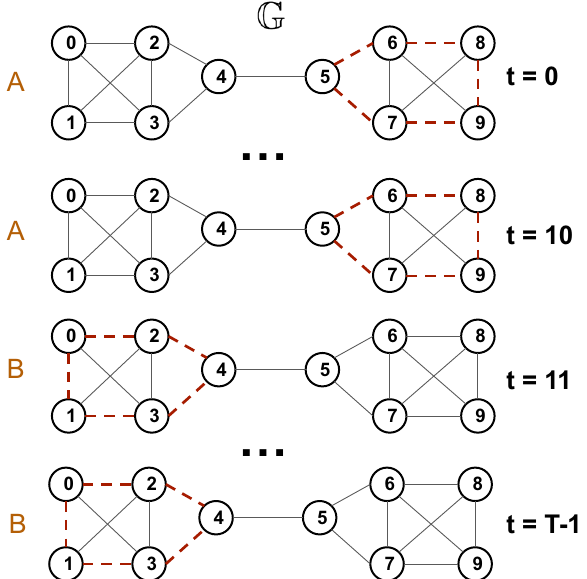
Figure 1. The example of a time-evolving graph with metastability where two states A and B are difficult to distinguish since they are topologically the same. Red dashed edges are removed from the time-evolving graph G